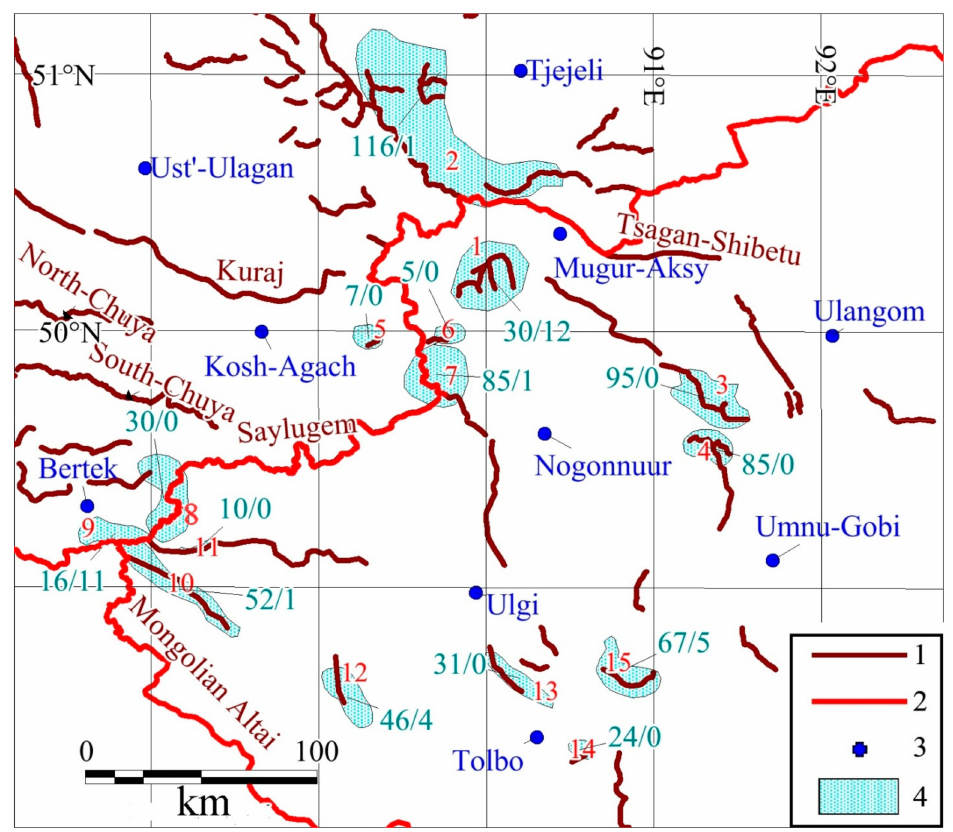
Figure 1. Current glaciation in the study area. Legend: objects: 1—mountain ridges; 2—state borders; 3—meteorological stations; 4—glaciated mountain areas; red numbers: